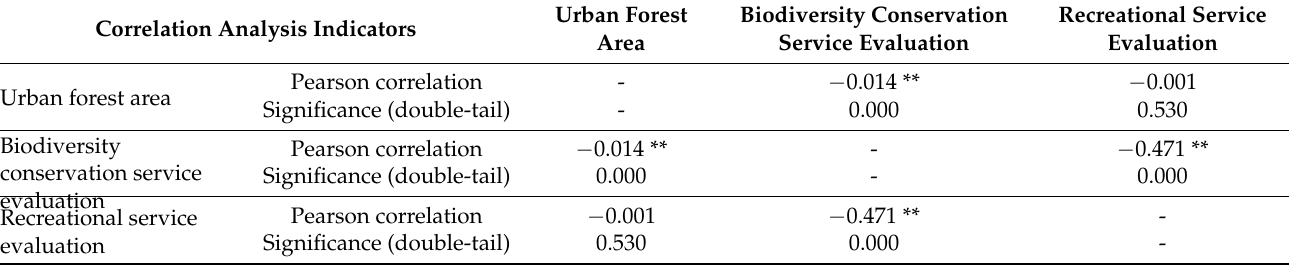
Table 7. Results of Pearson correlation coefficient analysis.